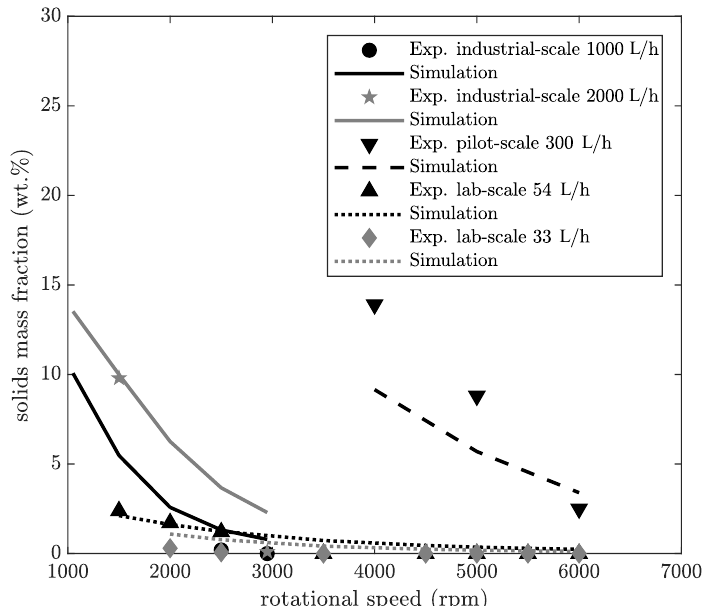
Figure 9. Solids mass fraction of the centrate for three decanter centrifuge scales, volumetric flow rates, and rotational speeds: Comparison of simulation and experiment for